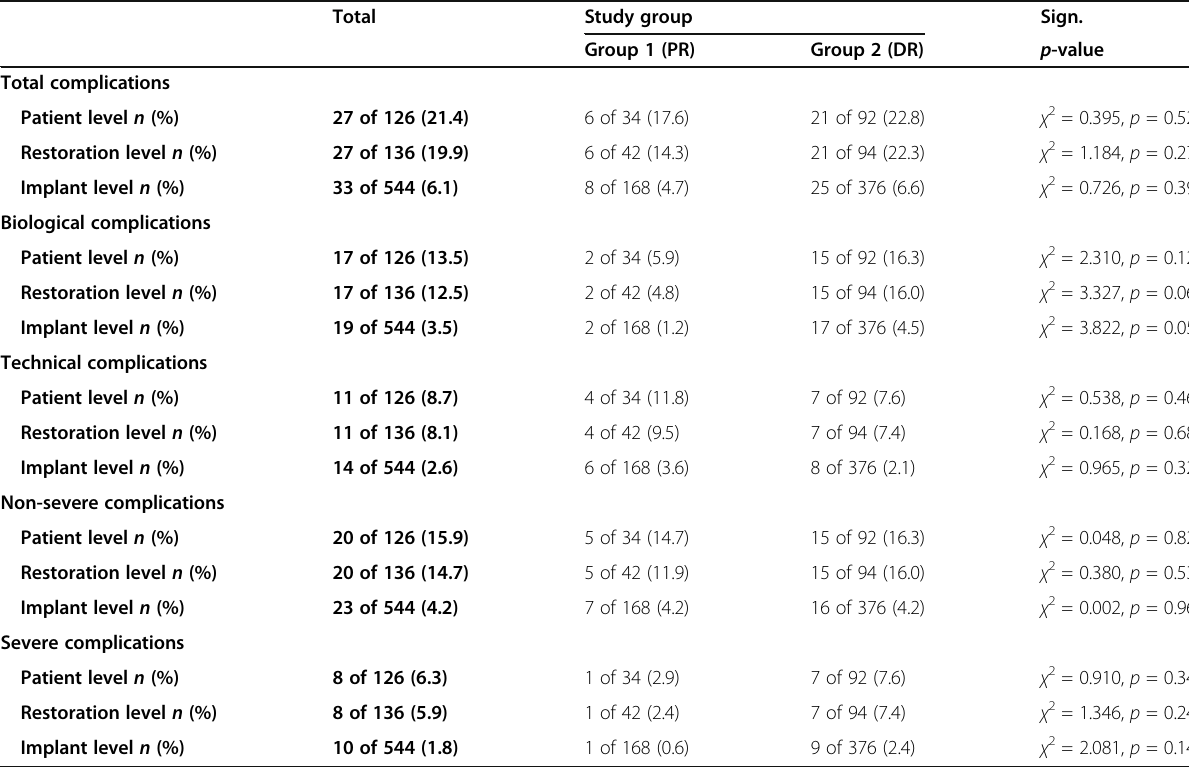
Table 3 Detailed patient-related complication rates of the study groups Total Study group